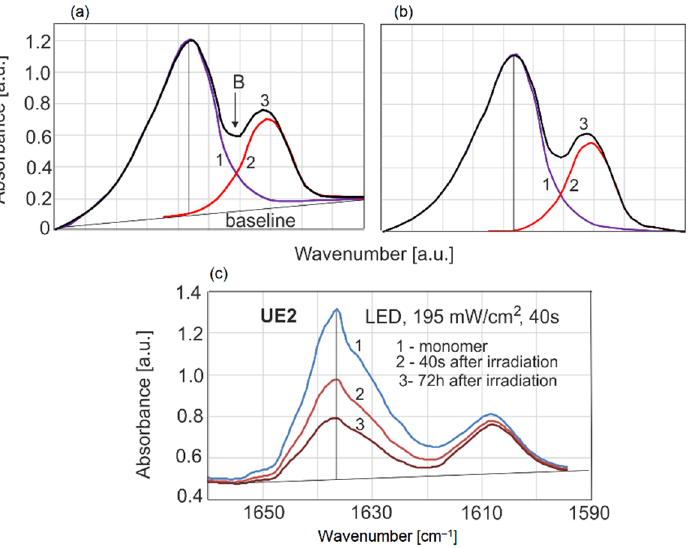
Figure 13. Overlapping of test and reference bands in methacrylate resins in the analytical model: ( a ) with baseline, ( b ) after baseline correction, ( c ) in experimental data. ( a ) with baseline, ( b ) after baseline correction, ( c ) in experimental